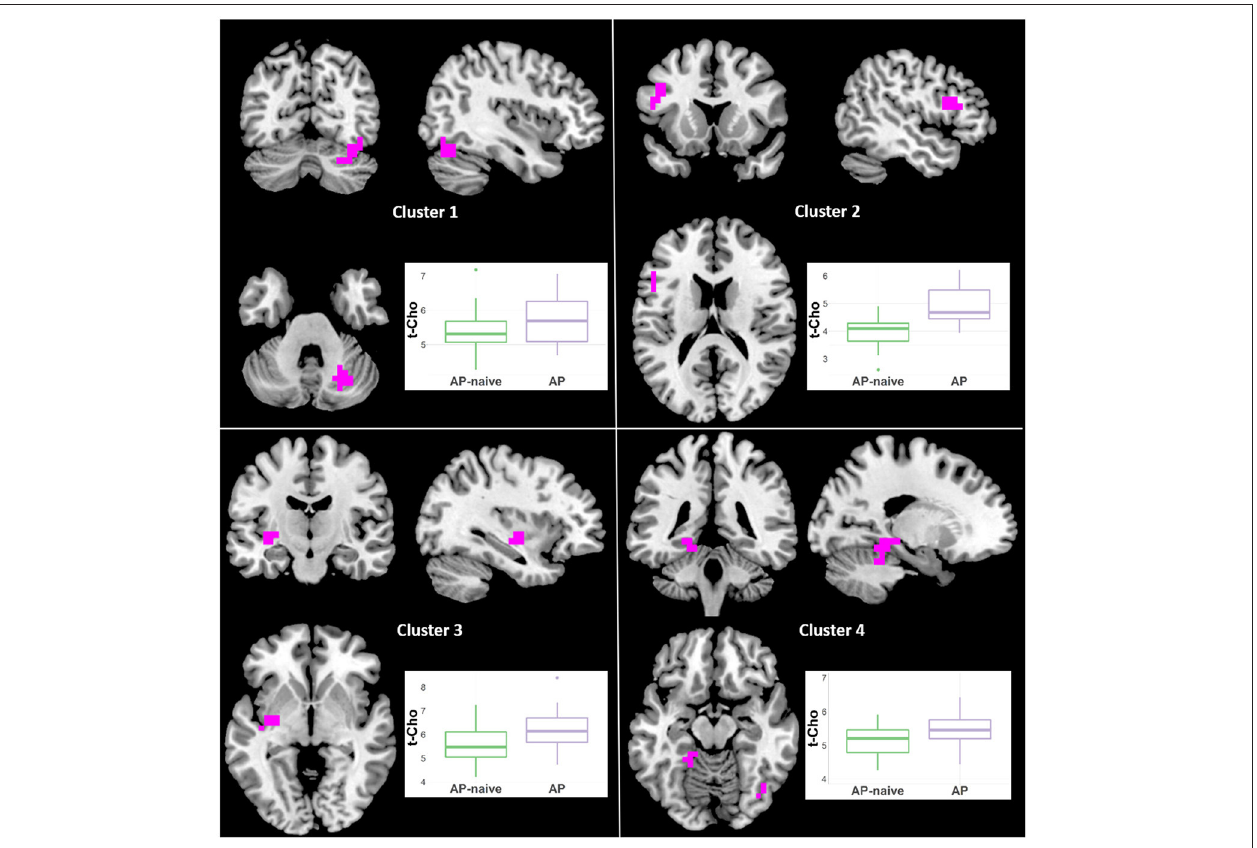
FIGURE 8 | Increased t-Cho in antipsychotic treated (AP) vs. antipsychotic naïve (AP-naive) Schizophrenia in four clusters: (1) 28 voxels; (CCLAV = 0.02), including the right declive (35.6%), right pyramis (19.6%), right tuber (16.3%), and right uvula (11%). (2) 23 voxels; (CCLAV = 0.03), including the left middle frontal gyrus (49.7%), and left inferior frontal gyrus (40%). (3) 18 voxels; (CCLAV = 0.03), including the left insula (21.7%), left claustrum (7.4%) and left lentiform nucleus (7.3%). (4) 16 voxels; (CCLAV = 0.04), including the left parahippocampal gyrus (46.9%), and the left culmen